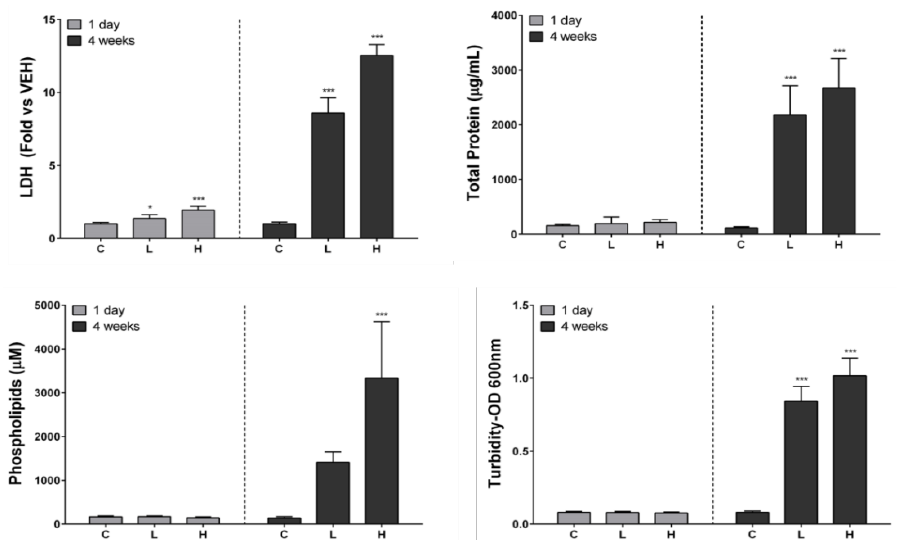
Figure 4. Biochemical analysis of bronchoalveolar lavage fluid (BALF) after intratracheal instillation of nickel oxide nanoparticles (NiO NPs). Lactate dehydrogenase (LDH) levels, total protein levels, turbidity, and phospholipid levels are indicated. Turbidity was measured as optical density at 600 nm. LDH, total protein, phospholipids, and turbidity level in the BALF significantly increased at 4 weeks after instillation. Data are presented as mean ± standard deviation (SD). One-way analysis of variance (ANOVA) was performed for the comparison between the NiO NPs-treated and control groups with statistical significance indicated by * p < 0.05 and *** p < 0.001. C: control group; L: low- dose group (50 cm 2 /rat); H: high-dose group (150 cm 2 /rat).